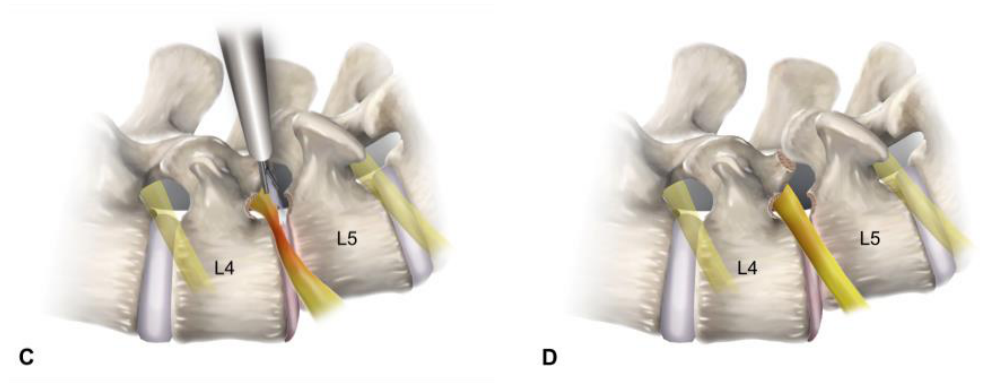
Figure 1. Schematic illustrations depicting the surgical procedure of full-endoscopic lumbar foraminotomy for foraminal stenosis with spondylolisthesis at the L4-L5 level. ( A ) Placement of the working sheath viewing the foraminal surgical field, avoiding the exiting nerve root (outside-in approach). ( B ) Bone works using endoscopic burrs for resecting the superior articular process and lower vertebral endplate. ( C ) Soft tissue decompression with removal of the ligamentum flavum and extruded disc. ( D ) End point of the full-scale foraminal decompression from the axillary to the lateral exit zone.